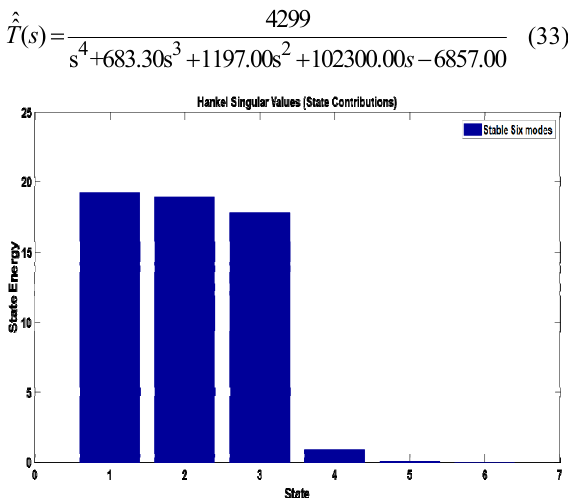
Figure 3. Hankel singular values plot of higher-order controller Design of the controller for balancing control of bi– cyrobo system under H-infinity full sustainable control procedure and strategies is developed by (Bui et al., 2008) [16,17] and the H-infinity (H ∞ ) controller is designed as